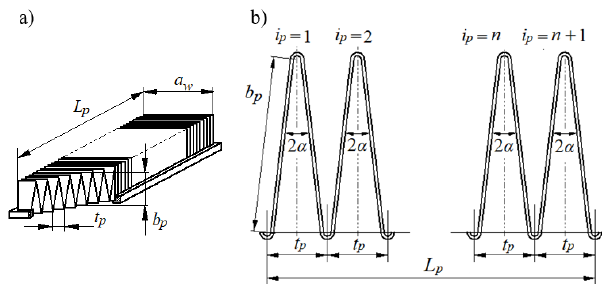
Fig. 4. Filter bed geometry: a) pleat geometry, b) i p – number of pleats, L p – insert length, a w – pleat width, b p – pleat side height, t p – pleat